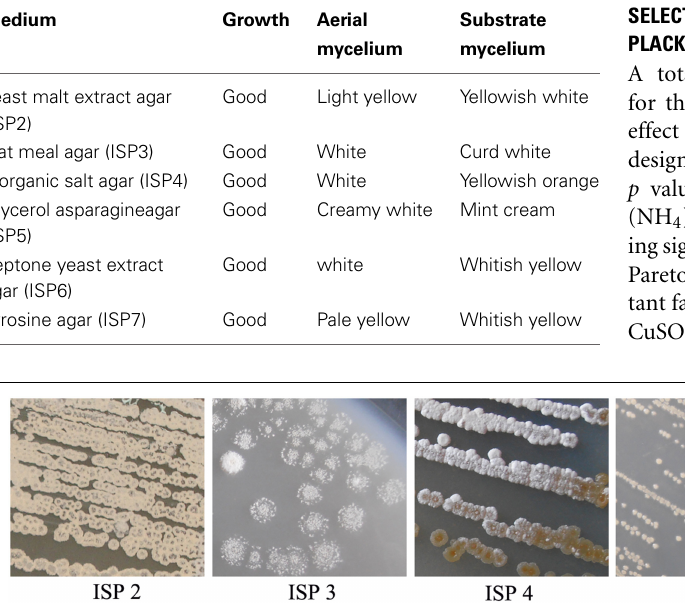
Table 6 | Cultural characteristics of strain JAJ13 on different ISP media.